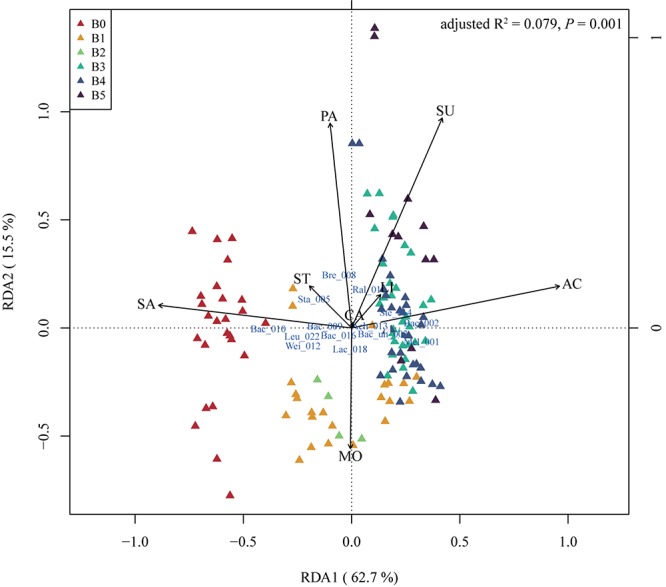
The redundancy analysis (RDA) triplot of the 126 mature samples. Hellinger-transformed OTUs table, constrained by eight physical and chemical properties, including acidity (AC), reducing sugar (SU), moisture (MO), starch (ST), saccharification (SA), liquefaction (LI), protease activity (PA), and cellulase activity (CA). The labels of OTUs are composed of the first three letters of taxa and the last three number of OTUs original names, “un” means unclassified. As there are too many OTUs to present, only OTUs with (weighted) orthonormal species scores of RDA1 and RDA2 greater than 0.15 are plotted. “Mel” – Melghirimyces, “Bac” – Bacillus, “Bac_un” – Bacillales_unclassified, “Sta” – Staphylococcus, “Bre” – Brevibacterium, “Ral” – Ralstonia, “Wei” – Weissella, “Ach” – Achromobacter, “Ste” – Stenotrophomonas, “Lac” – Lactobacillus, and “Leu” – Leuconostoc. B0 to B5 stands for six batches of mature starters.